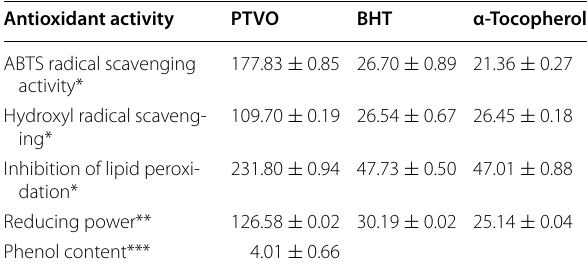
Table 2 Antioxidant activity of Porphyra tenera volatile oil (PTVO)